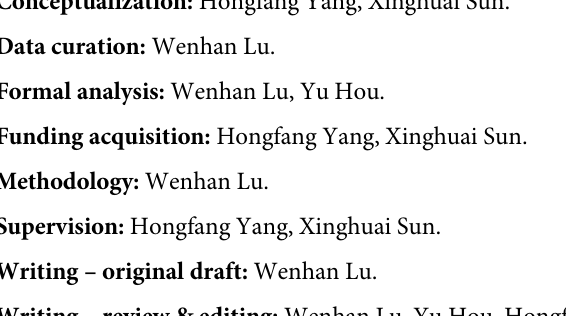
S3 Fig. Network funnel plot. Risk of publication bias of A. MAE, B. % ± 0.50 D and C. % ± 1.00 D was measured using network funnel plot showing symmetry, indicating relatively small publication bias. (TIFF) S4 Fig. The plotted node-splitting analysis. The decision rule selected Haigis-Hoffer Q com- parisons for MAE (A), Haigis-BUII, Haigis-Hoffer Q and Haigis-Kane comparisons for % ± 0.50 D (B) and % ± 1.00 D (C) because of presence of both direct and indirect comparisons in these pairs. As reflected by P-value, the direct and indirect comparisons were in agreement of each other. MAE: mean absolute error; BUII: Barrett Universal II. (TIFF) S1 Table. Detailed search results from different sources. (DOCX) S2 Table. Risk of bias of included studies. Level of evidence as recommended by the Oxford Centre for Evidence-based Medicine. � Retrospective Observational